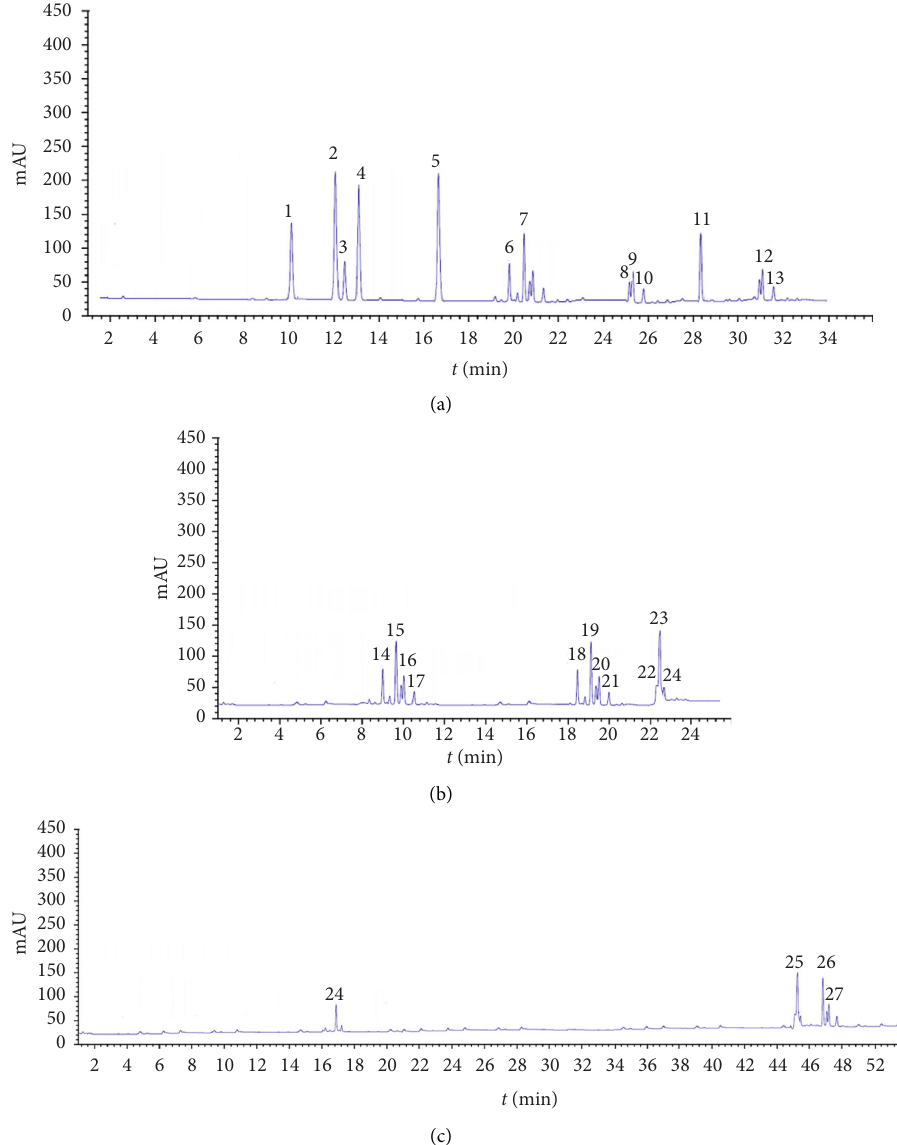
Figure 3: HPLC-DAD profile (560 nm (a) and 280 (b)nm 370) of the grape pomace